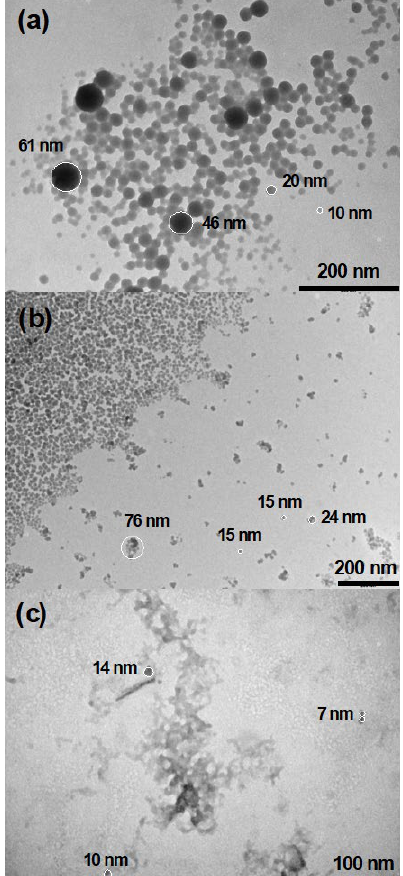
Figure 2. Transmission electron micrographies of nano-silicas (a) Cembinder 8 (b) Cembinder 30 and (c) Cembinder